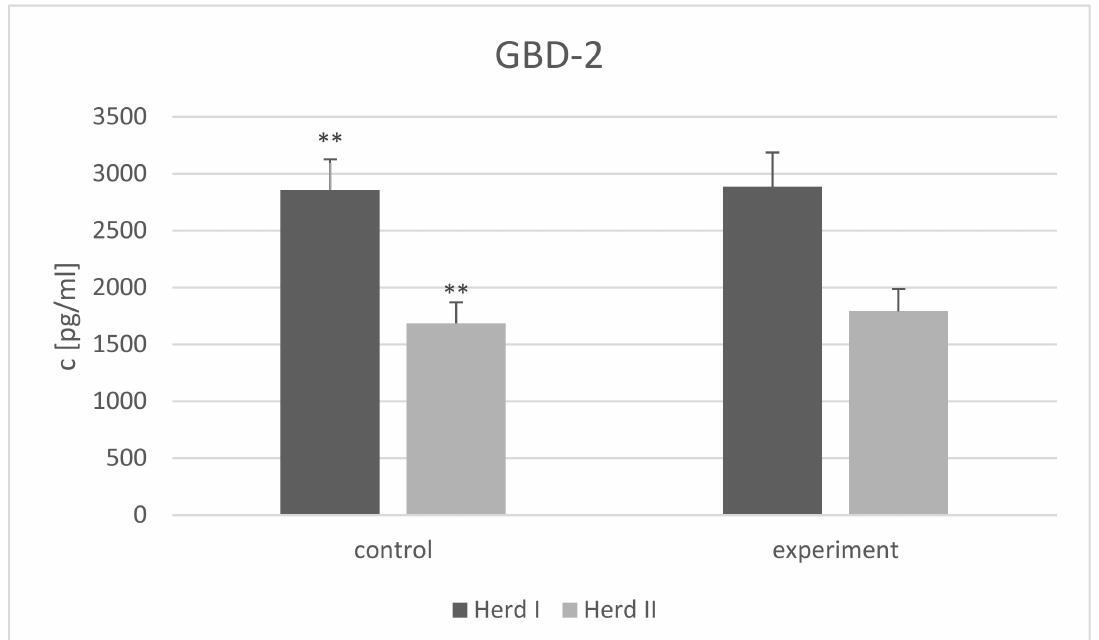
Figure 1. β 2-defensin 2 (GBD-2) concentration (c) (presented as LSMEAN value with standard errors) in the milk of goats from two herds; Herd I control group—supplemented with inor- ganic selenium (sodium selenite), Herd II control group—without any supplementation, Herd I experimental group—supplemented with organic selenium (selenized yeast), Herd II experimental group—supplemented with spice-herb mixture, ** differences between the control groups from both herds p <